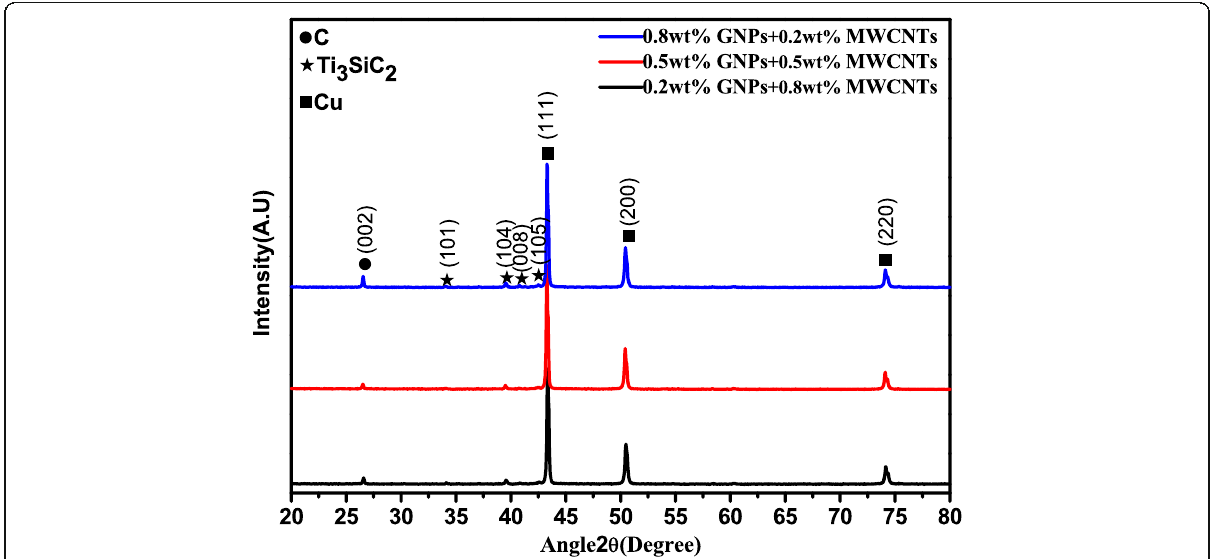
Fig. 2 XRD patterns of raw materials after ball milling. Nanocomposites with 0.8 wt% graphenes and 0.2 wt% MWCNTs, nanocomposites with 0.5 wt% graphenes and 0.5 wt% MWCNTs, and nanocomposites with 0.2 wt% graphenes and 0.8 wt%